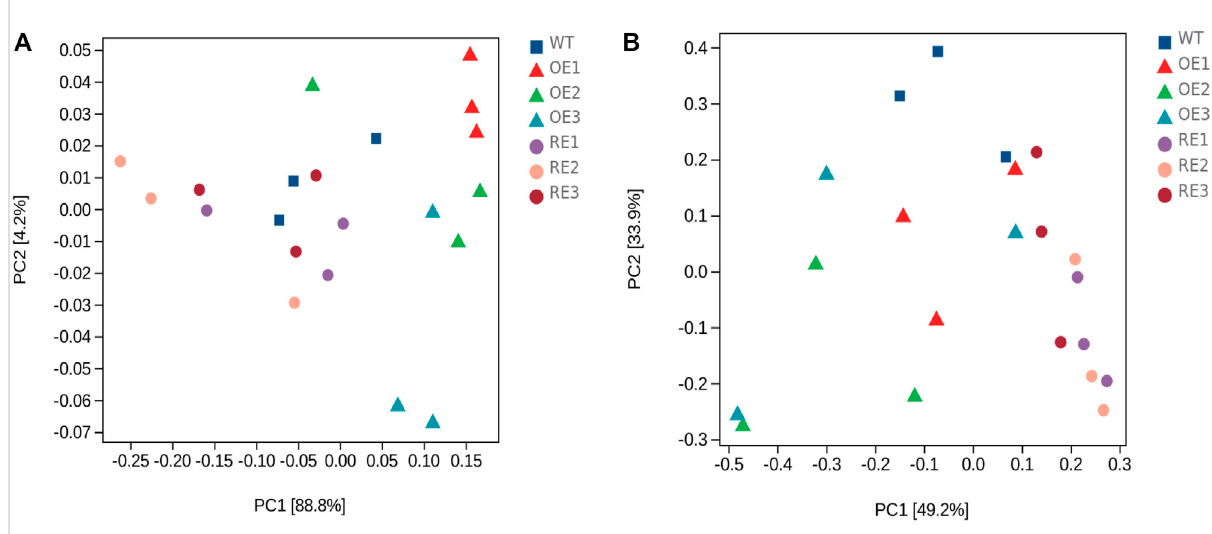
FIGURE 4 PCA of bacterial and fungal community genera in rhizosphere soil between transgenic PaGLK and WT poplar. (A) Bacteria (B) Fungi.